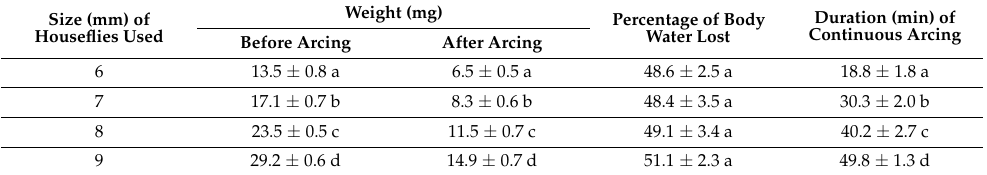
Weight (mg) Duration (min) of